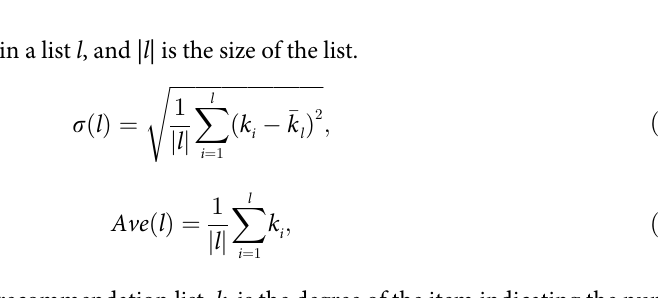
Fig 7. Diversity comparison results of DSS and other algorithms. The larger the result, the more disperse the degree distribution of items in the recommendation list given by the algorithm, and the better the diversity of the recommendation list.